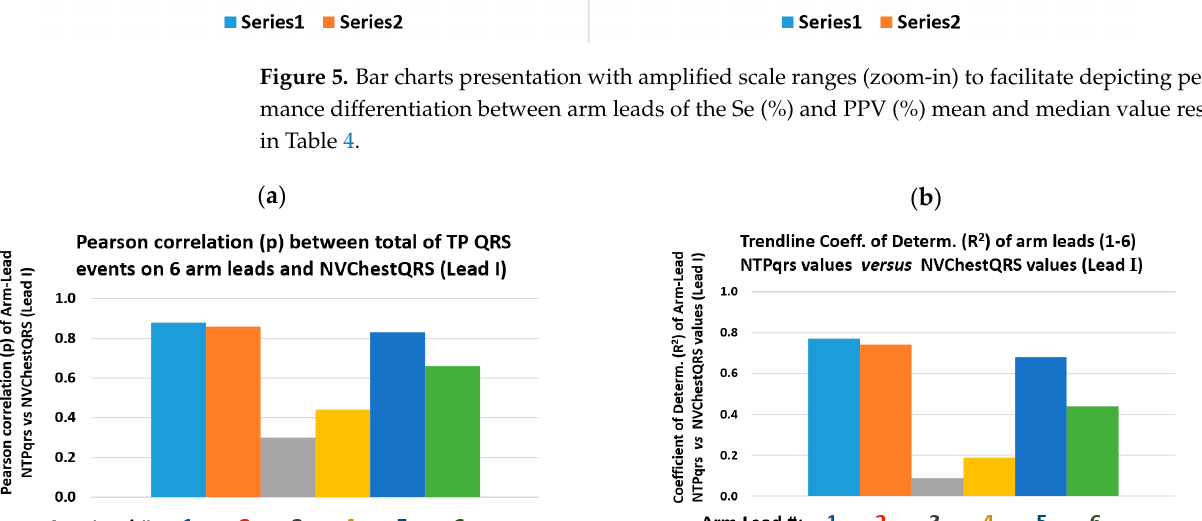
Table 5. Results summary of Pearson Correlation coefficient (p) and scatter plot (Figure 7) associated trendline coefficient of determination (R 2 ) between number of valid QRS events in the Chest Lead I (NVChestQRS) and the number of true positive QRS (NTPqrs) events on the six bipolar arm leads.